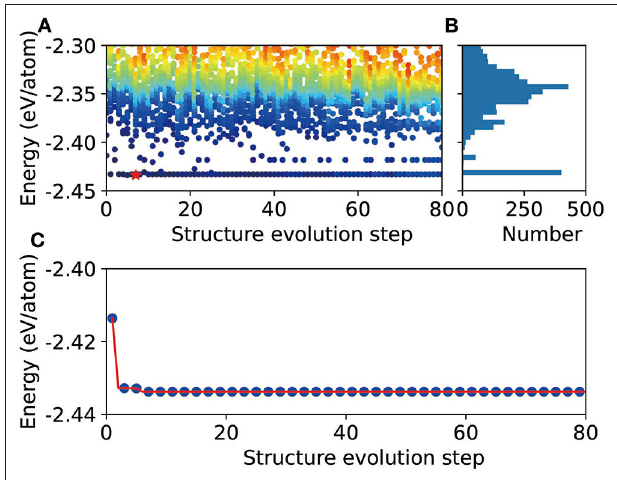
FIGURE 1 | Schematic illustration of the DP+CALYPSO process for the Mg 12 Al 8 system. (A) Evolution of the energies of all structures during the structure prediction process. The red star indicates the global minimal structure. (B) Energy histogram. (C) Evolution of the lowest energy during the structure prediction process.